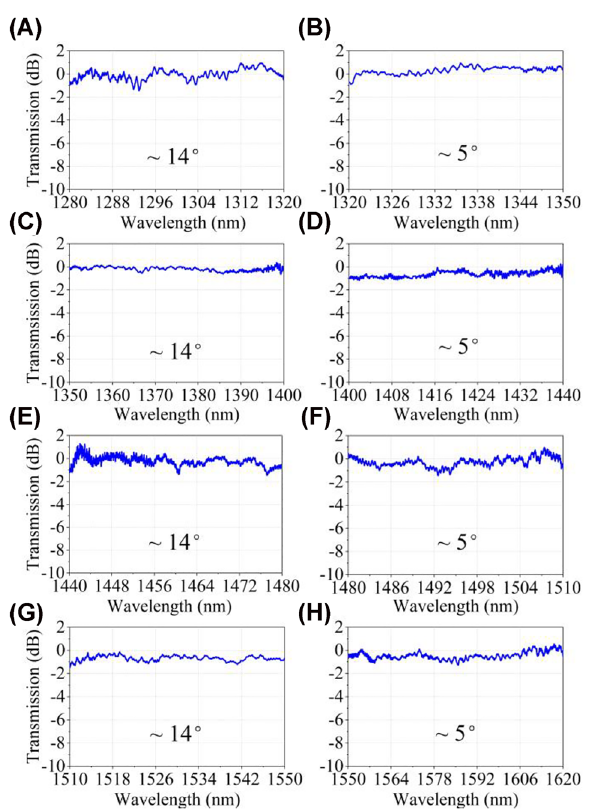
Figure 7: Experimental transmission spectra of the on-chip GRIN metalens. The transmission spectra in the wavelength ranges of (A) 1280–320 nm (C) 1350–1400 nm, (E) 1440–1480 nm, and (G) 1510–1550 nm are tested with a tilted angle of ∼ 14 ◦ . The transmission spectra in the wavelength ranges of (B) 1320–1350 nm (D) 1400–1440 nm, (F) 1480–1510 nm, and (H) 1550–1620 nm are measured with a tilted angle of ∼ 5 ◦